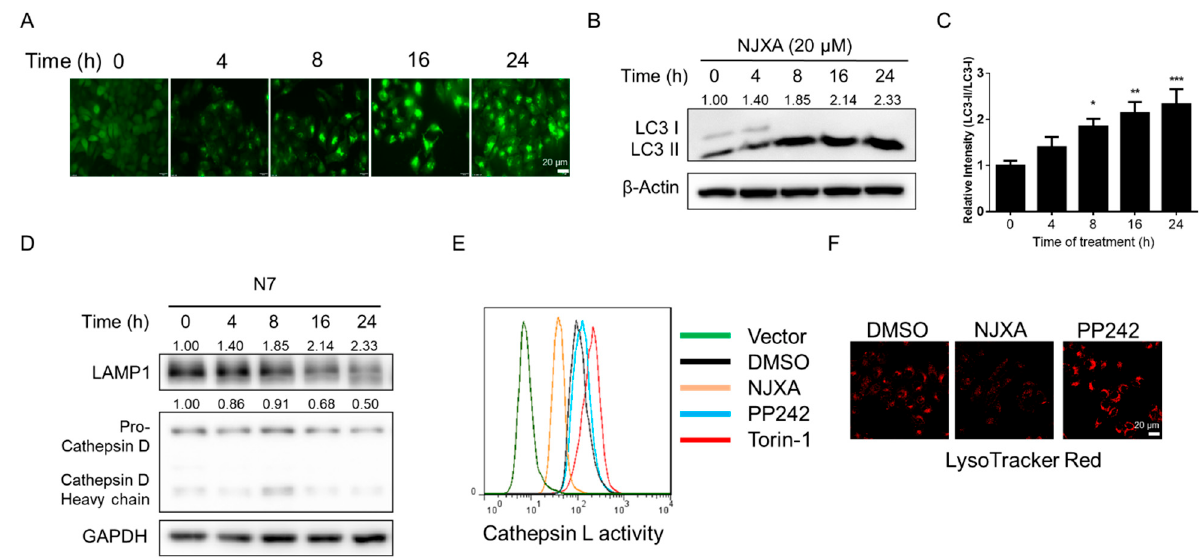
Figure 4. NJXA promotes mitochondria–lysosome fusion without activating lysosomal function. ( A ) GFP ‐ LC3 HeLa cells were treated with NJXA (20 μ M) for 0–24 h. The distribution of GFP ‐ LC3 was examined by immunofluorescence microscopy. Scale bar = 20 μ m. ( B ) HeLa cells treated with NJXA (20 μ M) for 0–24 h were analyzed by immunoblotting for LC3, and β‐ actin served as the loading control. ( C ) ImageJ densitometric analysis of the LC3 ‐ II/LC3 ‐ I ratio from the immunoblots is shown (mean ± SD of three independent experiments). * p < 0.05, ** p < 0.01, and *** p < 0.001. ( D ) HeLa cells were treated with NJXA (20 μ M) for 0–24 h, collected, and analyzed by immunoblotting for LAMP1 and cathepsin D. GAPDH served as the loading control. The values above the bands indicate the relative 669 band intensities. Data are presented as the means ± SEM of three independent experiments. HeLa cells were treated with NJXA (20 μ M), PP242 (1 μ M), or torin ‐ 1 (1 μ M) for 4 h. ( E ) Cells were labeled with Magic Red Cathepsin L reagent for 30 min and assessed by flow cytometry. ( F ) Alternatively, cells were labeled with LysoTracker Red (50 nM) and analyzed by fluorescence microscopy.